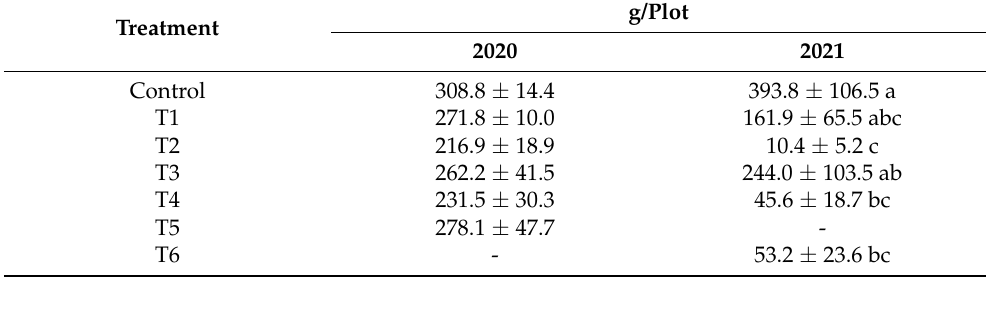
Table 5. Dry weight (g) biomass of C. bonariensis in July 2021. Mean values ± standard errors of the mean. Different letters denote significant differences among treatments at p < 0.05. T1: acetic acid 20% + N32, T2: potassium metabisulfite + pelargonic acid 31%, T3: pelargonic acid 68%, T4: humic-fulvic acid, T5: hydroxy phosphate complex, T6: potassium metabisulfite.